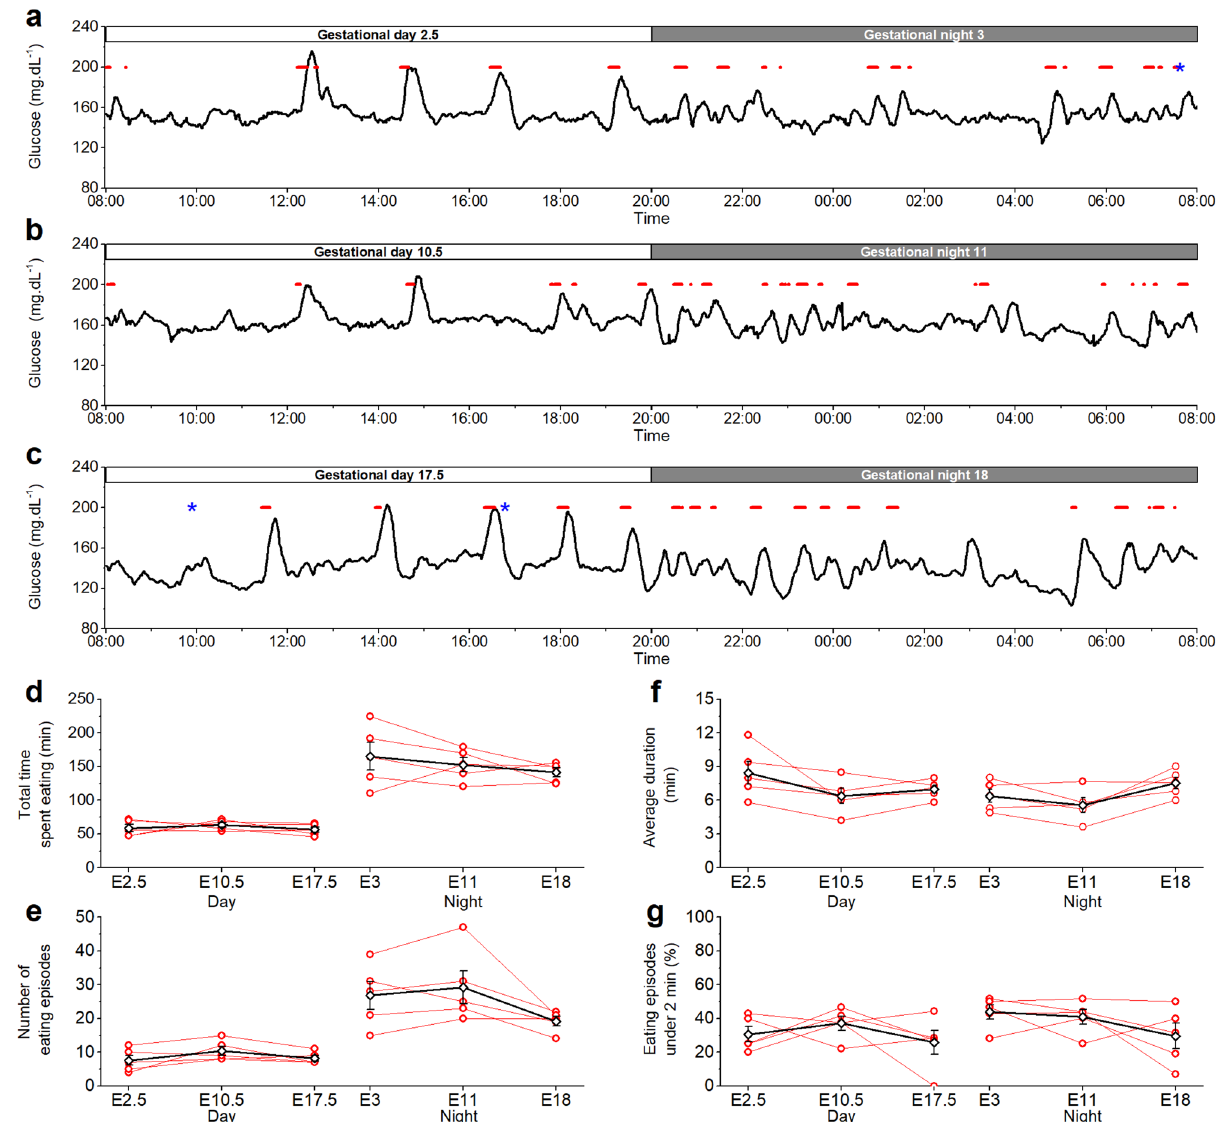
Figure 5. Glycaemia linked to eating behaviour. ( a ) Feeding episodes (red) of one day and night in the beginning of pregnancy (E2.5, E3), ( b ) in the middle of pregnancy (E10.5, E11) and ( c ) at the end of pregnancy (E17.5, E18) in relation to the blood glucose levels. On E3 and E17.5, the mouse was shortly disturbed (blue*). Representative examples of one mouse. ( d ) Individual total time that the mice spent eating during the day and night in the beginning, middle and end of pregnancy. Time spent eating is significantly different during day and night and stays different over the course of pregnancy (p = 0.0042, **). ( e ) Number of eating episodes during the day and night in the beginning, middle and end of pregnancy. Mice eat significantly more often during the night compared to the day (p = 0.037,*). ( f ) Average duration of an eating episode is similar at all times during pregnancy. ( g ) The percentage of short eating episodes is similar at all times during pregnancy. ( b – e : red open bullets: individual data points per mouse, black open diamonds: mean ± s.e.m., Two-way ANOVA, n = 5